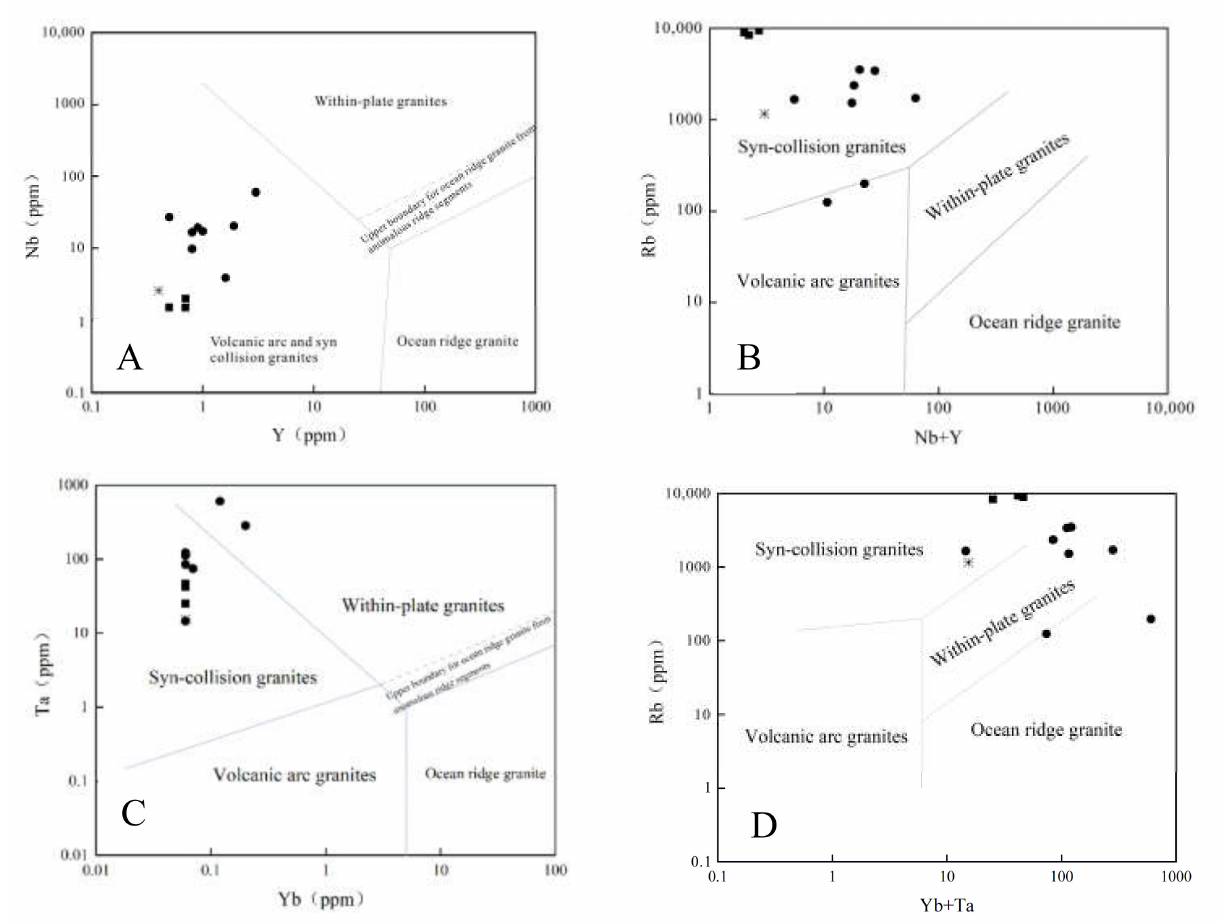
Figure 9. Tectonic discriminant diagrams of WPG and syn-GOLG suites of the Kenticha granite- pegmatite; Symbols are the same as Figure 6. A-All the rock samples fall in volcanic arc and syn-collision granites domain; B-Most of the rock samples fall in syn-collision granites domain; C-Most of the rock samples fall in syn-collision granites domain; D-Parts of the rock samples fall in syn-collision granites domain, while others fall in within-plate granites domain except for one outlier. The combination of the four subfigures indicates that the pegmatites in Lijiapuzi should be related to